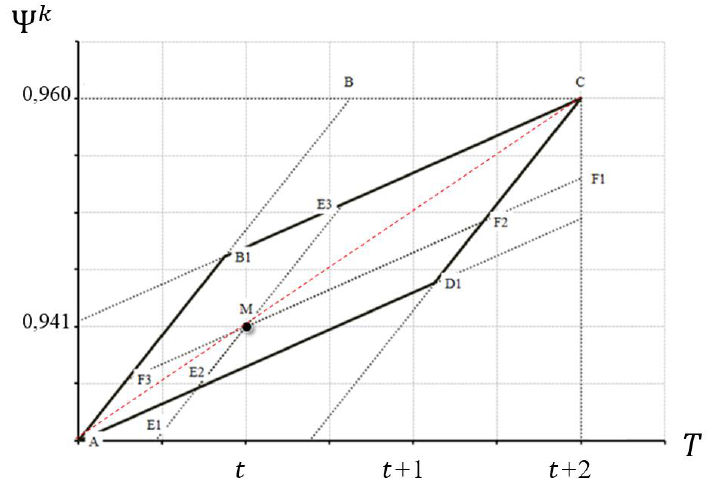
Figure 2. Calculated example. Initial